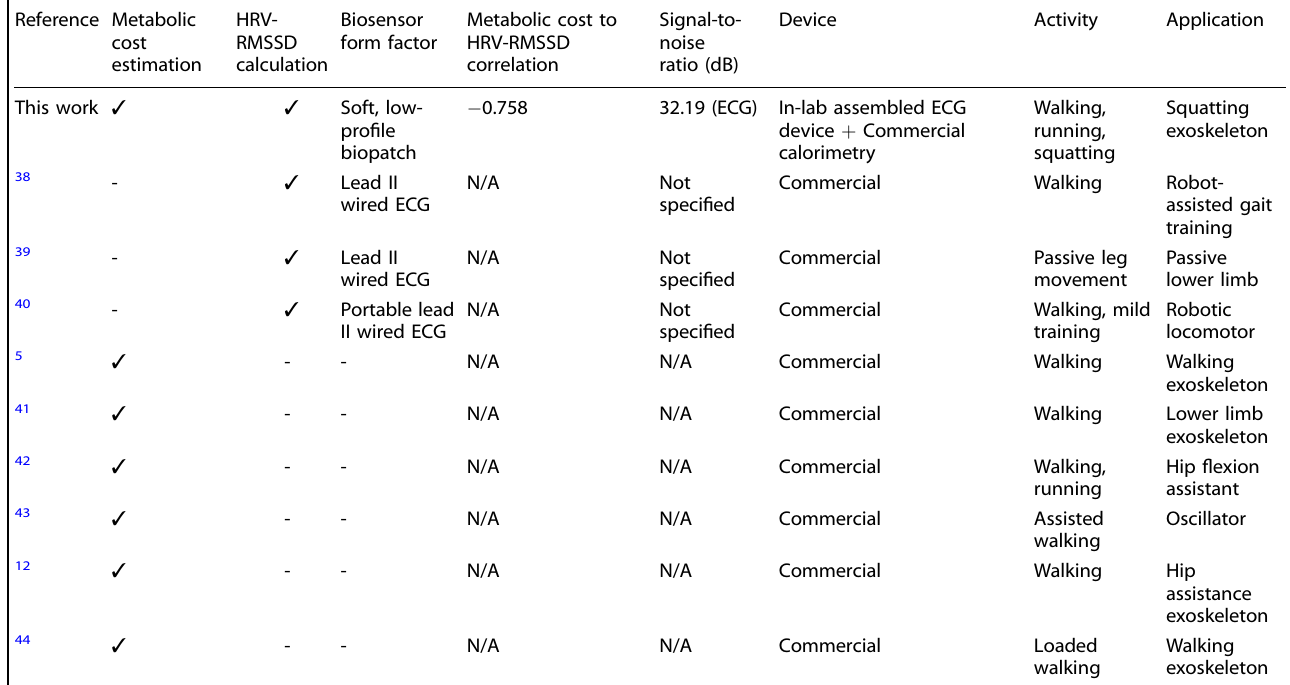
Table 1. Comparison of recent exosuit studies for estimation of metabolic costs and physical